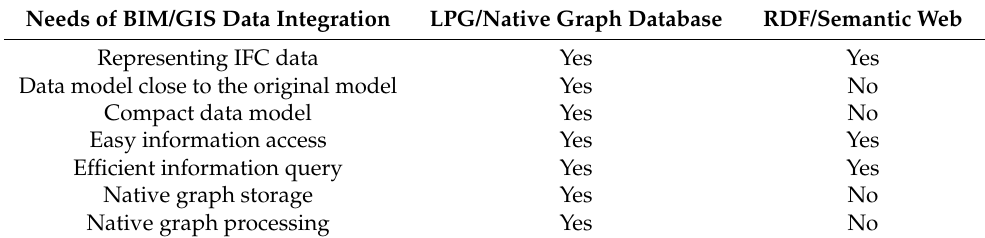
Table 2. Comparison between LPG and